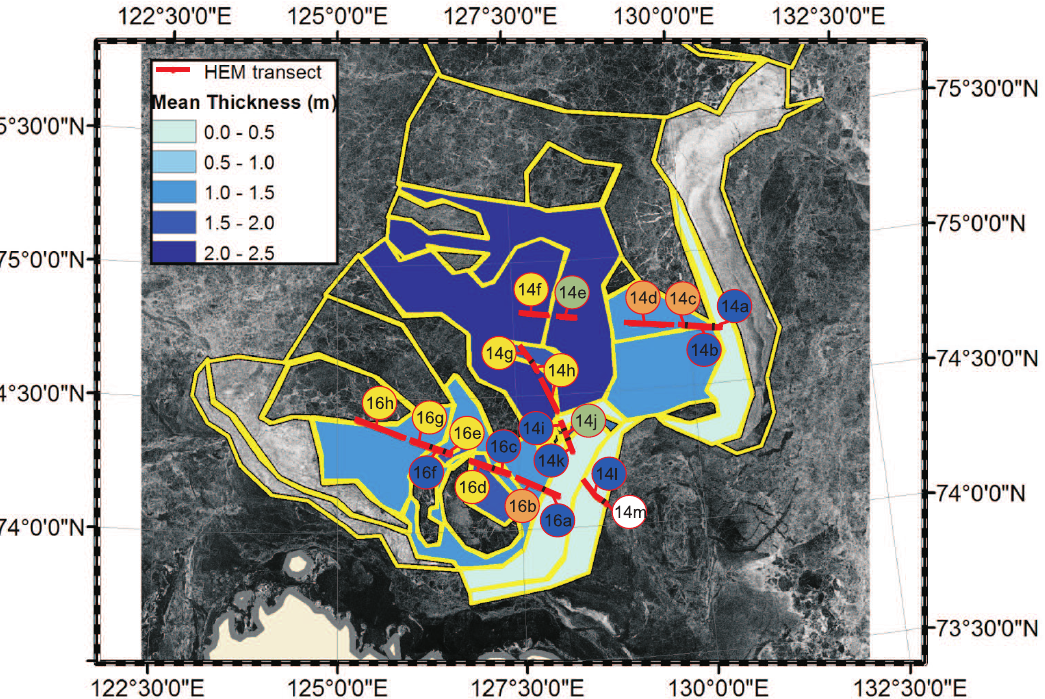
Fig. 5. Map with all HEM sea-ice thickness profiles. Northern and southern profiles flown on 14 and 16 April are coded 14a–m and 16a–h, respectively. Circle colors refer to the polynya events in which the respective surveyed sea ice formed (for color code, see Table 1). The yellow lines on the SAR map show a classification of the survey area in zones of the same age. The blue colors refer to the mean thickness of the corresponding HEM cross profile.